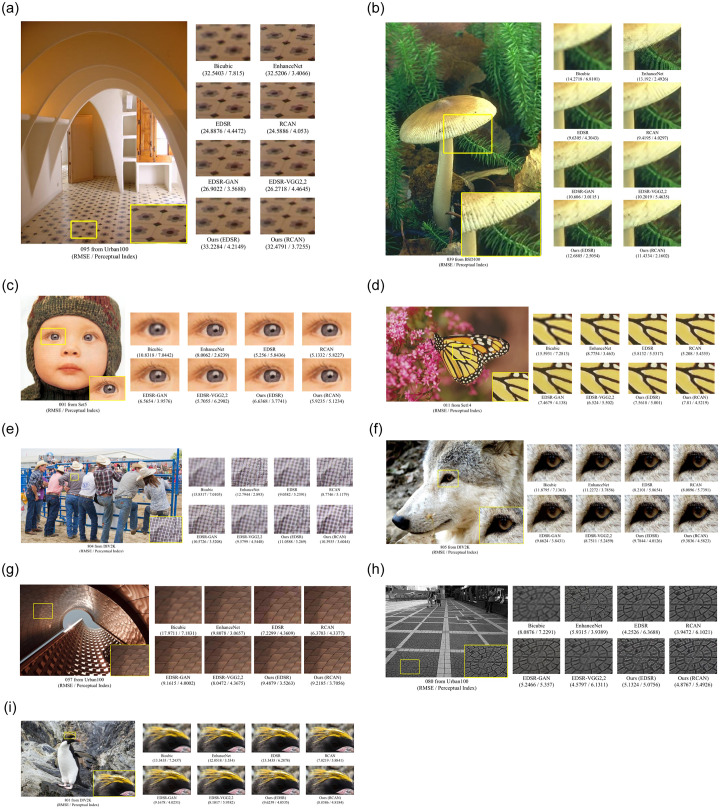
Visual effects and quantitative comparison (RMSE and Perceptual Index) of our methods with Bicubic, EnhanceNet, RCAN, EDSR-GAN and EDSR-VGG 2,2.(a) shows the results of 095.png from Urban100 dataset, (b) shows the results of 039.png from BSD100 dataset, (c) shows the results of 001.png from Set5 dataset, (d) shows the results of 011.png from Set14 dataset, (e) shows the results of 804.png from DIV2K dataset, (f) shows the results of 805.png from DIV2K dataset, (g) shows the results of 057.png from Urban100 dataset, (h) shows the results of 080.png from Urban100 dataset, (i) shows the results of 801.png from DIV2K dataset.